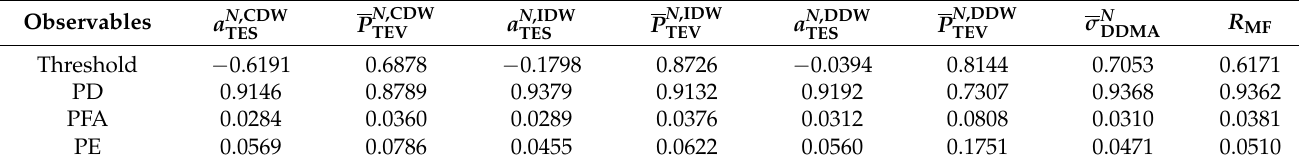
Table 1. The classification threshold and the probability of different DDM observables.